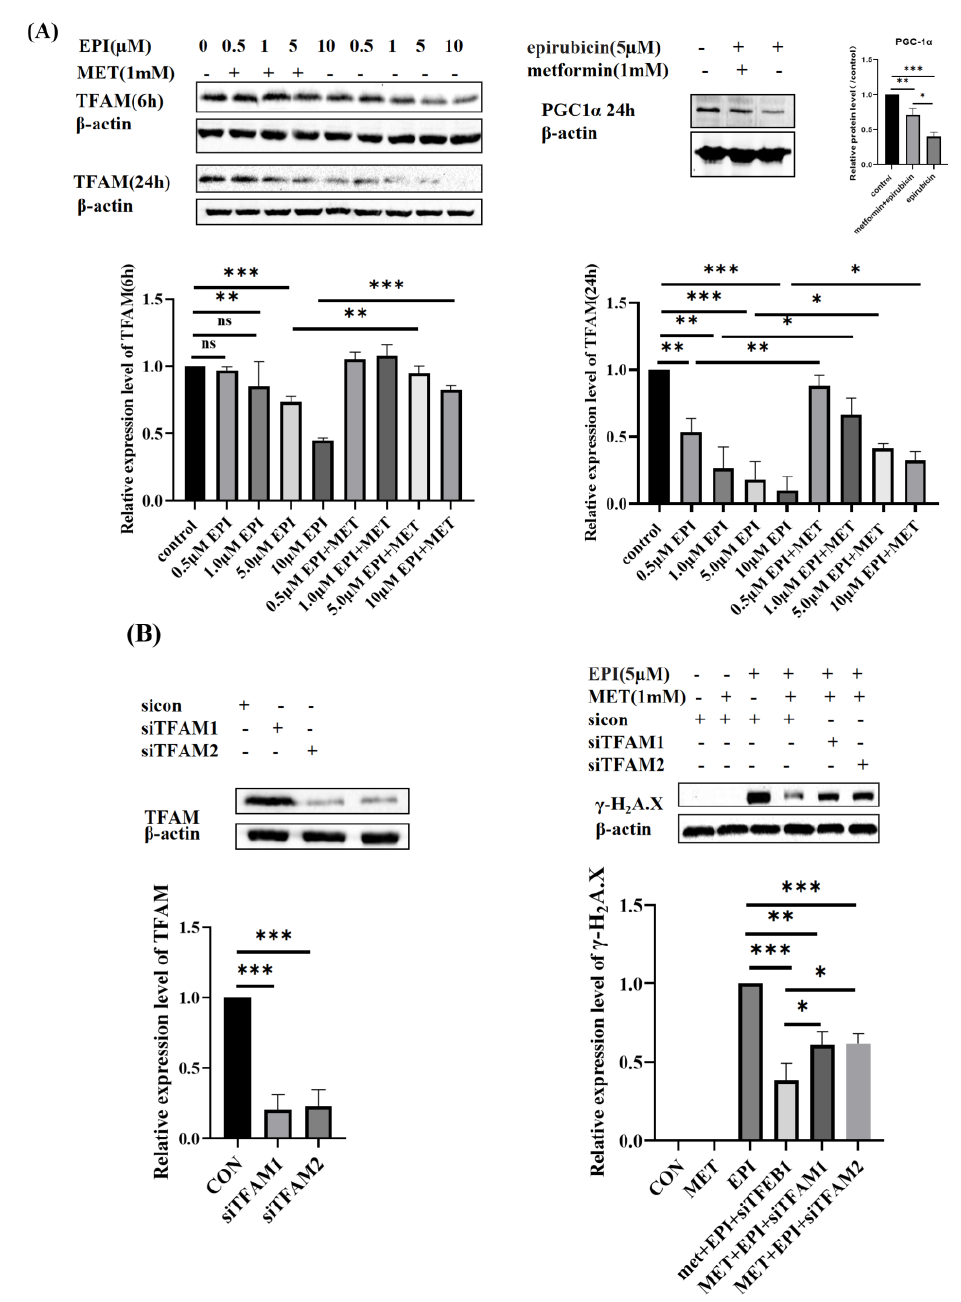
Figure 2. Metformin restores mitochondrial biogenesis. ( A ) Expression levels of TFAM and PGC1 α . HUVEC cells were treated with incubated with 0.5 µ M, 1 µ M, 5 µ M or 10 µ M EPI, respectively, for 6 h or 24 h with or without the pretreatment of metformin (1 mM) for 12 h. TFAM expression was detected by Western blotting. HUVEC cells were treated with 5 µ M epirubicin for 24 h with or without the pretreatment of 1 mM metformin for 12 h, then PGC1 α expression was detected by Western blotting. ( B ) Expression levels of γ − H2A.X. HUVEC cells were incubated with TFAM siRNA or control siRNA for 48 h. HUVEC cells were treated with 5 µ M epirubicin for 24 h with or without the pretreatment of 1 mM metformin for 12 h. The levels of γ − H2A.X were detected by Western blotting. The epirubicin treatment group was used as the reference. EPI—epirubicin, MET—metformin, ns—not significant, * p < 0.05, ** p < 0.01, *** p <